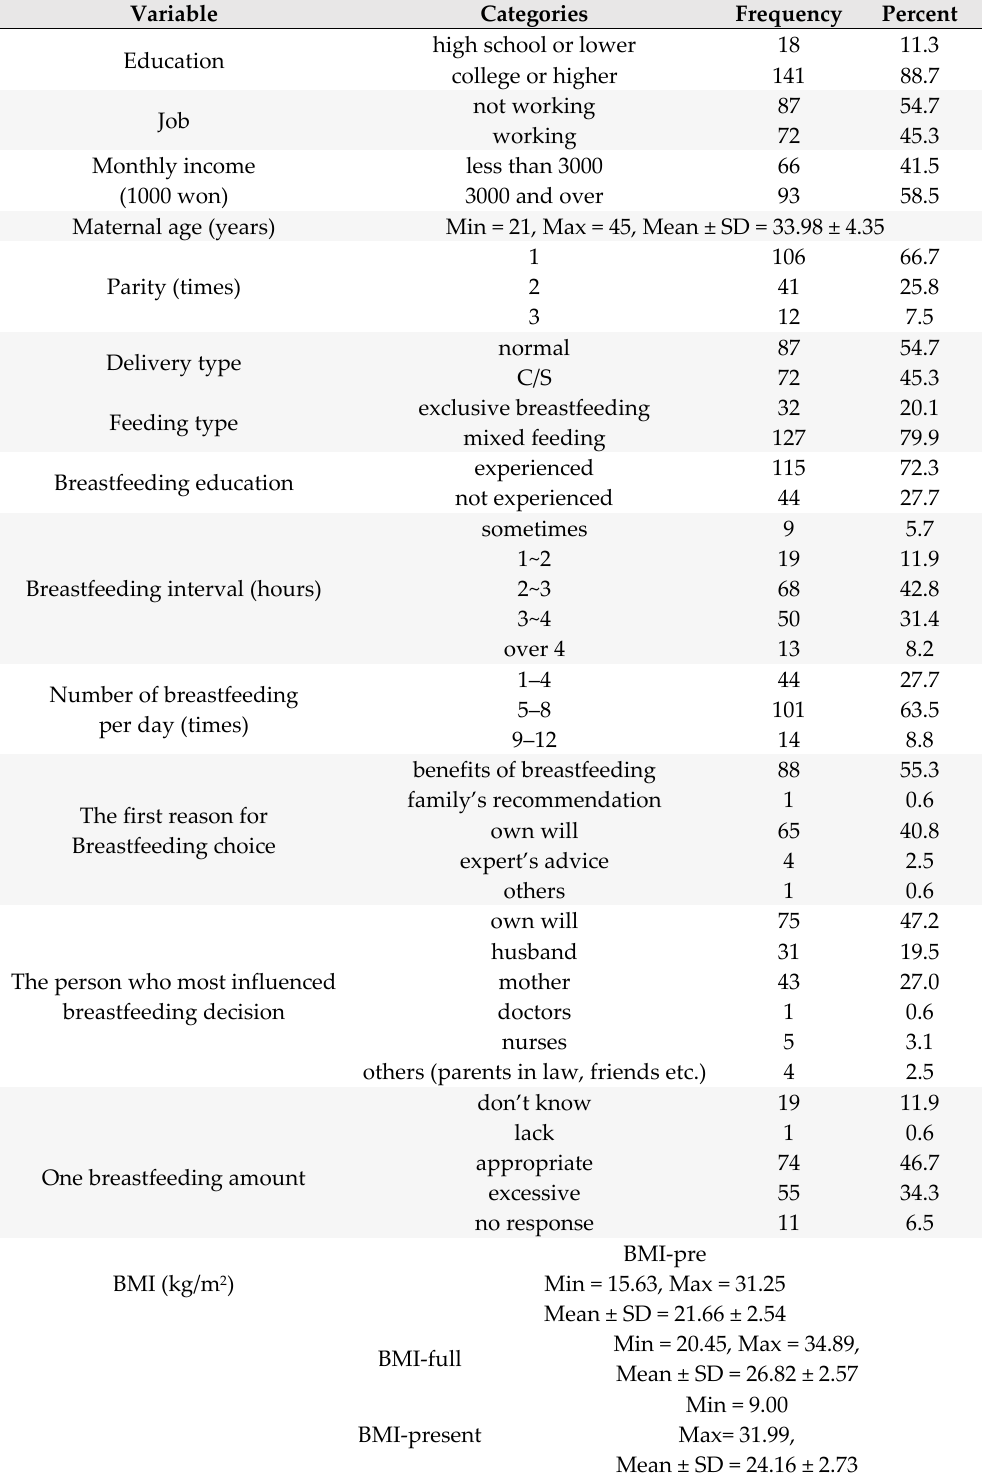
Table 1. General characteristics of participants ( n = 159).